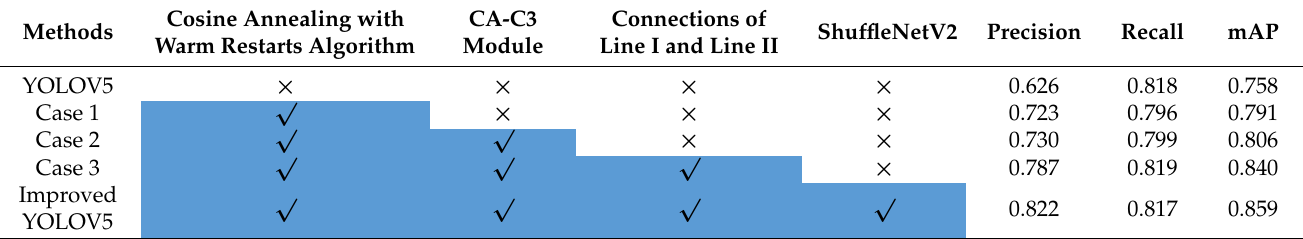
Table 3. Comparative results of ablation